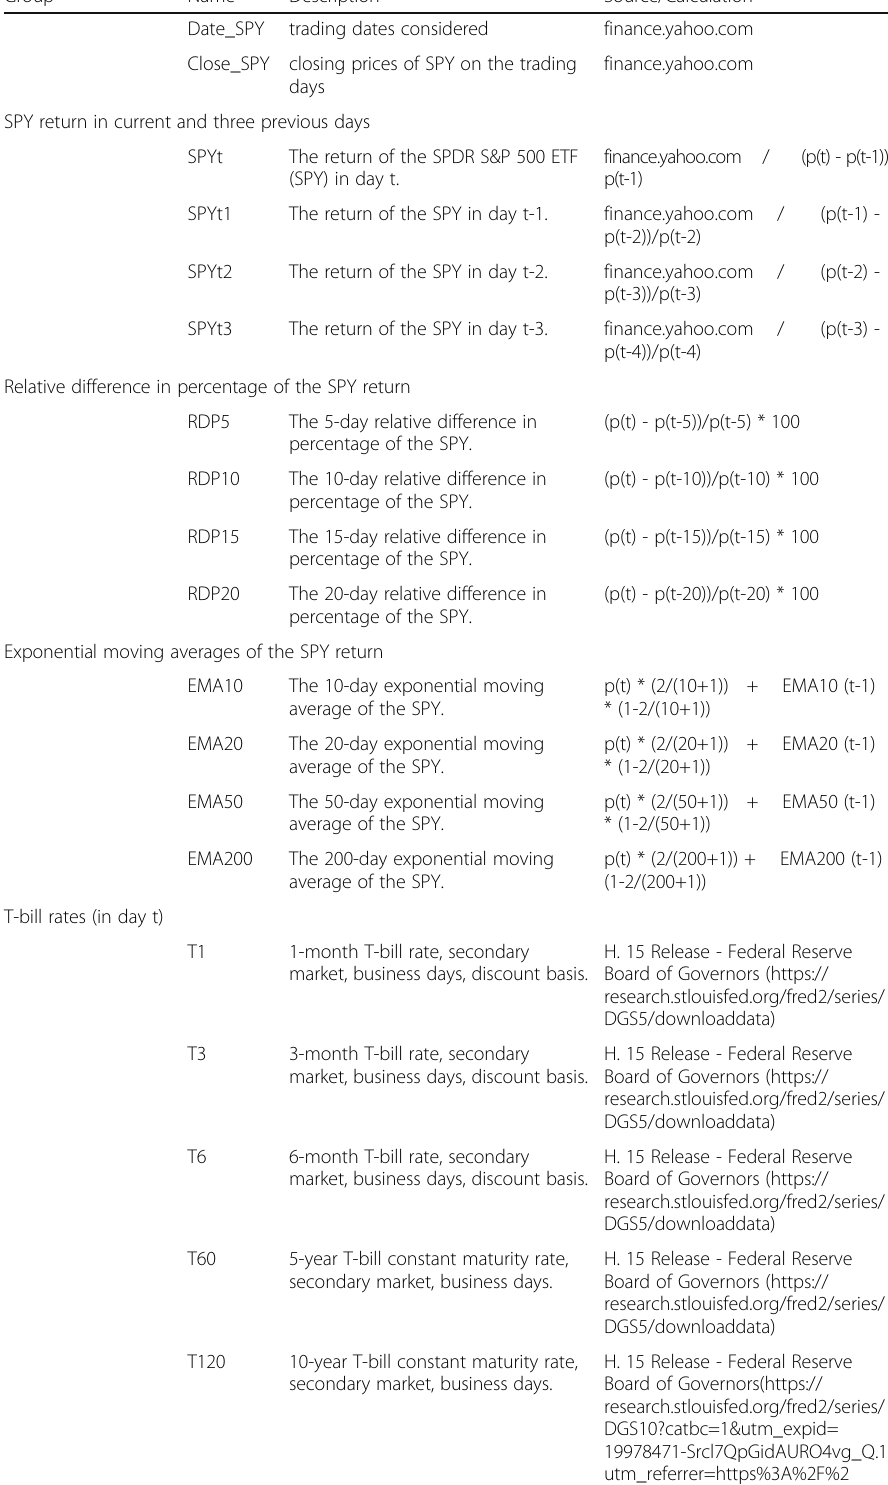
Table 10 The 60 financial and economical features of the raw data